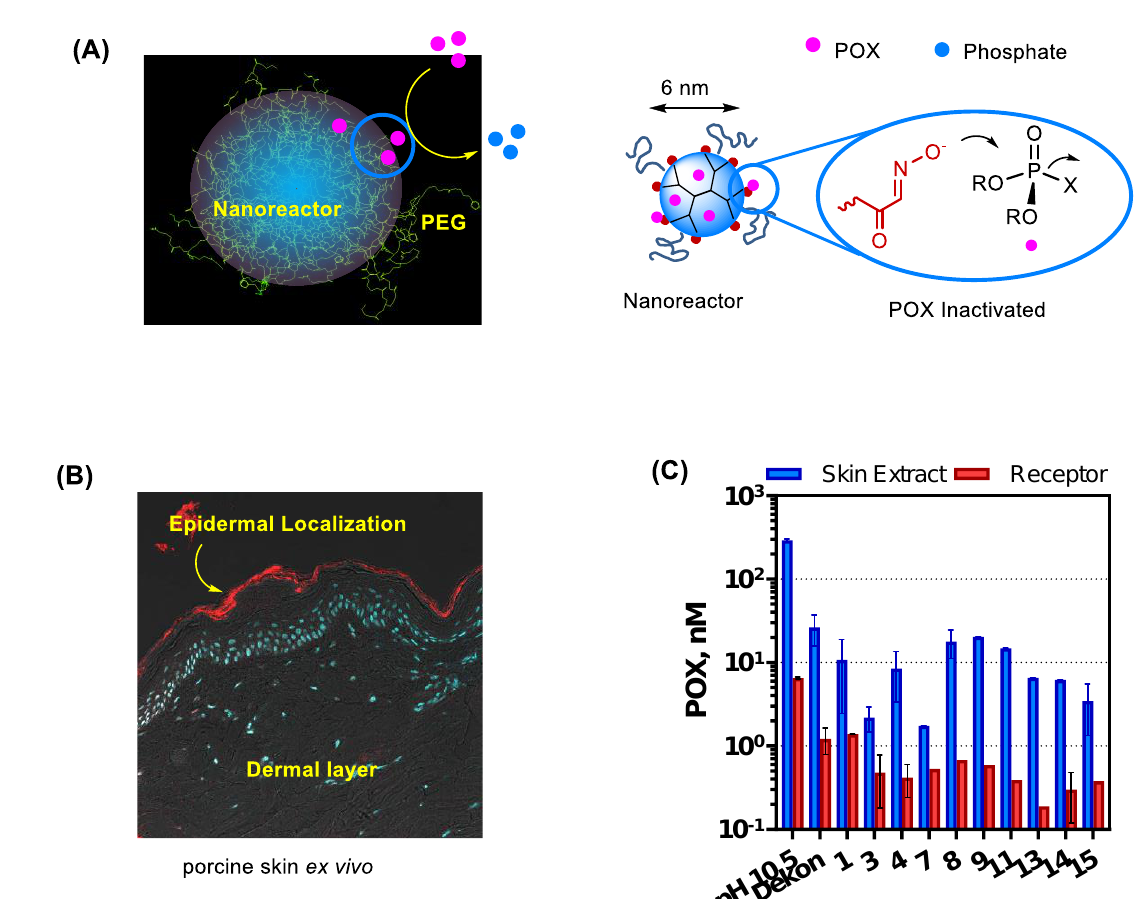
Figure 9. G5 PAMAM dendrimer-cored nanoreactors developed for topical decontamination of organophosphate (OP). ( A ) A proposed model for shielded oxime nanoreactor (left) and its mode of action in POX inactivation (right). ( B ) A confocal fluorescent image of the cryosection from porcine skin treated with Cy5 dye-labeled dendrimer nanoreactor ex vivo. ( C ) Efficacy of POX decontamination by a series of shielded oxime nanoreactors screened in porcine skin ex vivo. Reproduced with permission from [37], Copyright 2020, American Chemical Society.